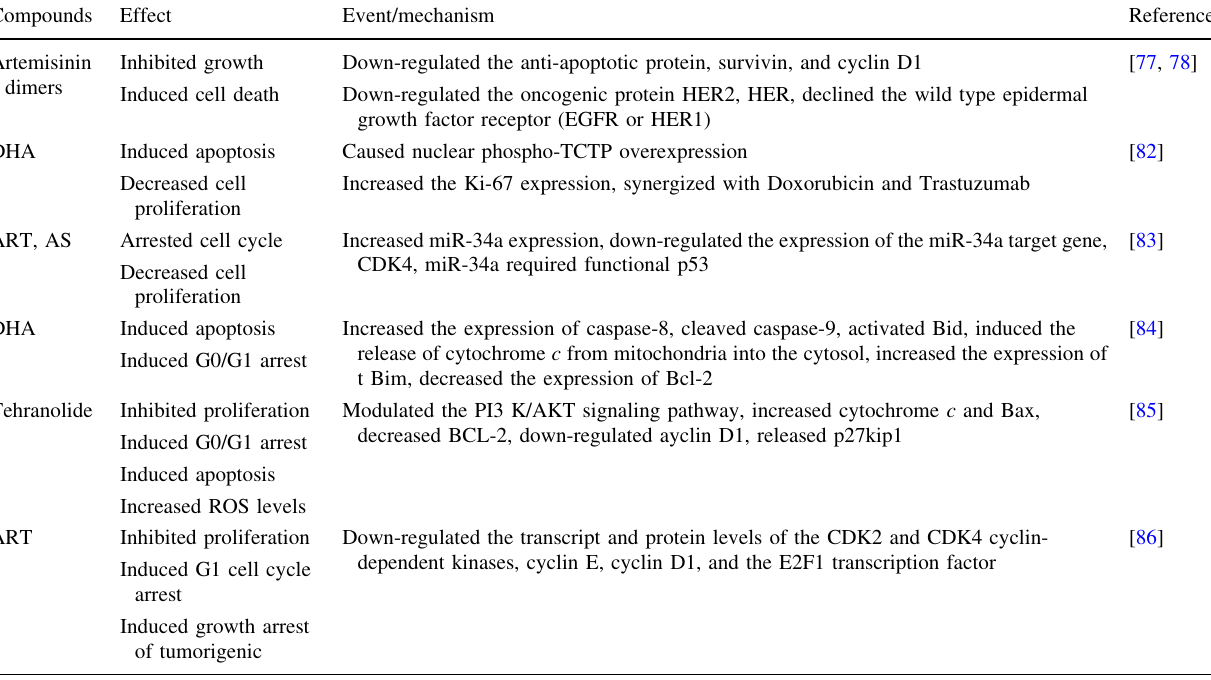
Table 2 Anti-breast cancer cells activities of artemisinins